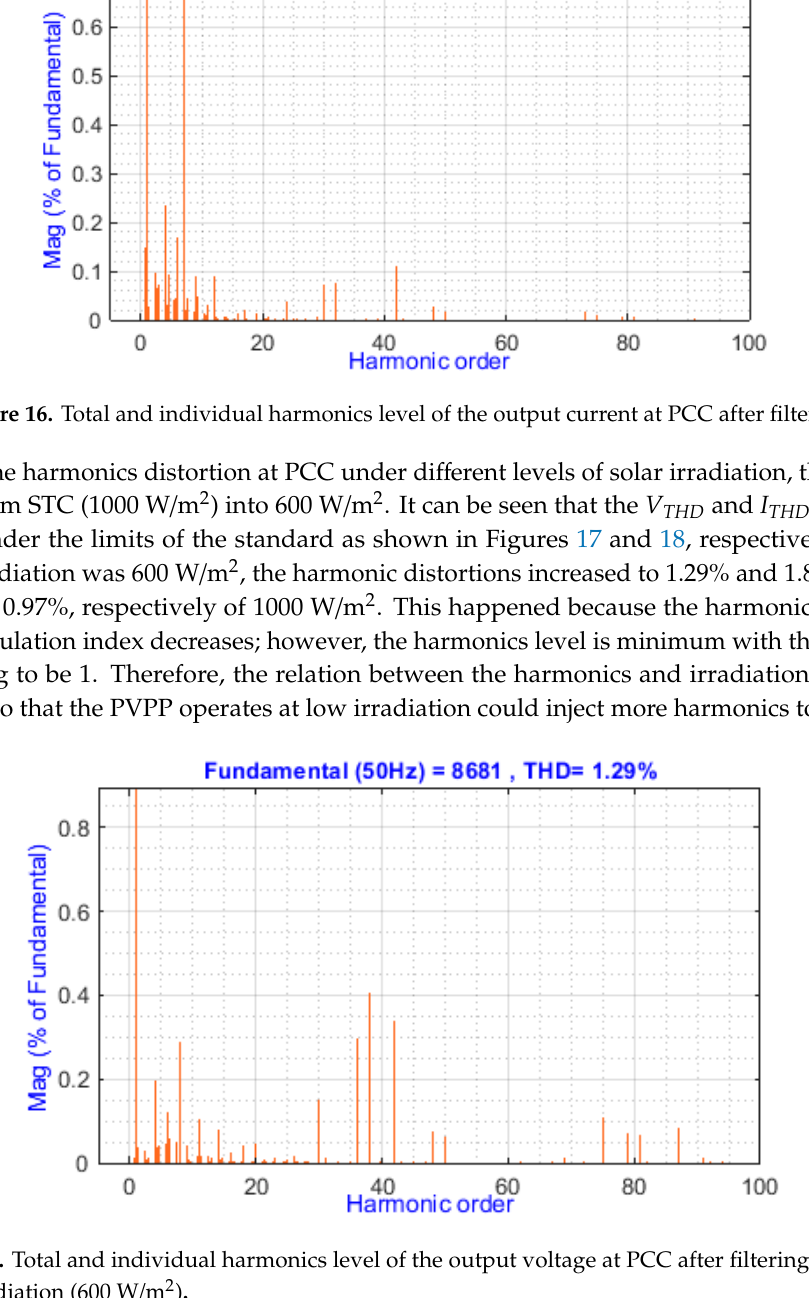
solar irradiation (600 W/m 2 ) .